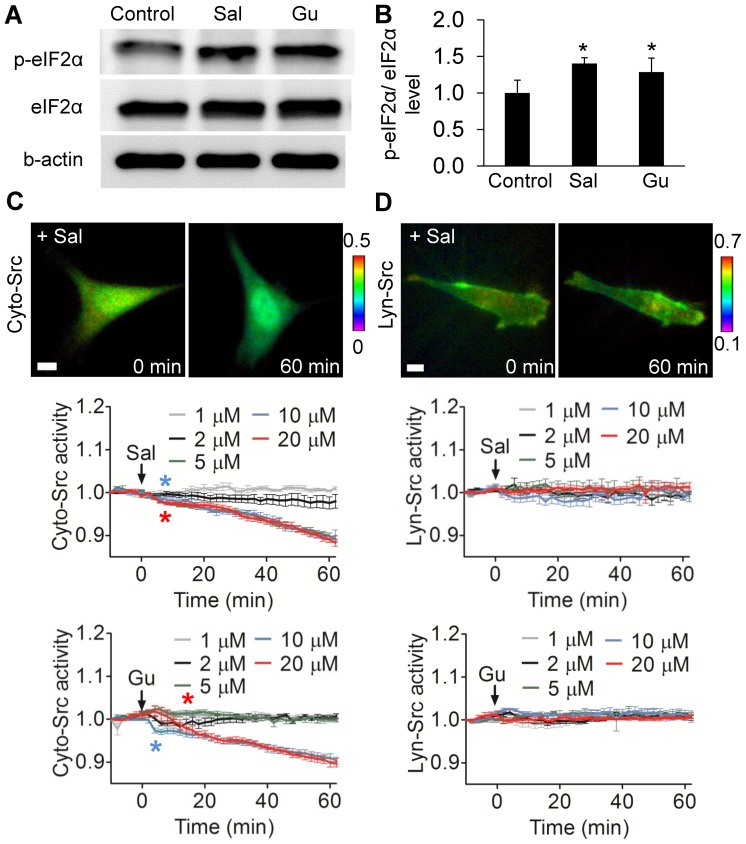
Salubrinal (Sal) and guanabenze (Gu) increase phosphorylation of eIF2α and decrease Cyto-Src activities.(A) Western blots showing the elevated level of p-eIF2α by salubrinal and guanabenz. (B) Staining intensity of p-eIF2α, normalized by intensity of eIF2α. * p<0.05. (C) Cyto-Src activity by salubrinal and guanabenz. (D) Lyn-Src activity by salubrinal and guanabenz. Scale bars, 10 µm. n>7 cells.